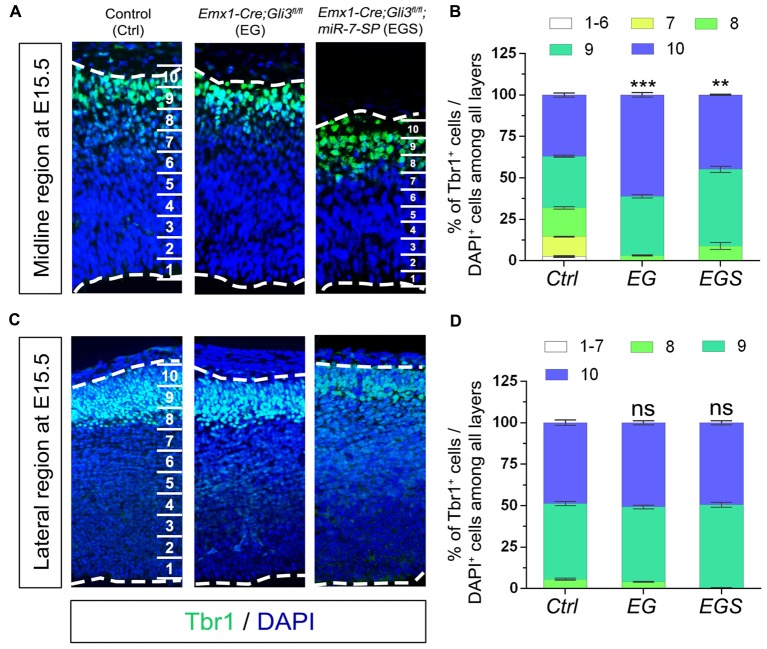
The regulatory role of Gli3 and miR-7 in neuronal migration in E15.5 cortices. (A,B) Absence of Gli3 facilitated more Tbr1+ marked neurons to migrate into the upper-bins (bin10) in the midline region, while double-lose of miR-7 and Gli3 corrected the migratory process. (C,D) No significant alteration of migratory process was detected in the bin10 in the lateral region in EG and EGS cortices. The markers BrdU, Tbr1 and DAPI stained for proliferative NPs, newborn neurons and all cells, respectively. Values represent mean ± SEM. n > 9. **P < 0.01; ***P < 0.001; ns, not significant. One-way ANOVA with post hoc test was used. Scale bar = 50 μm.